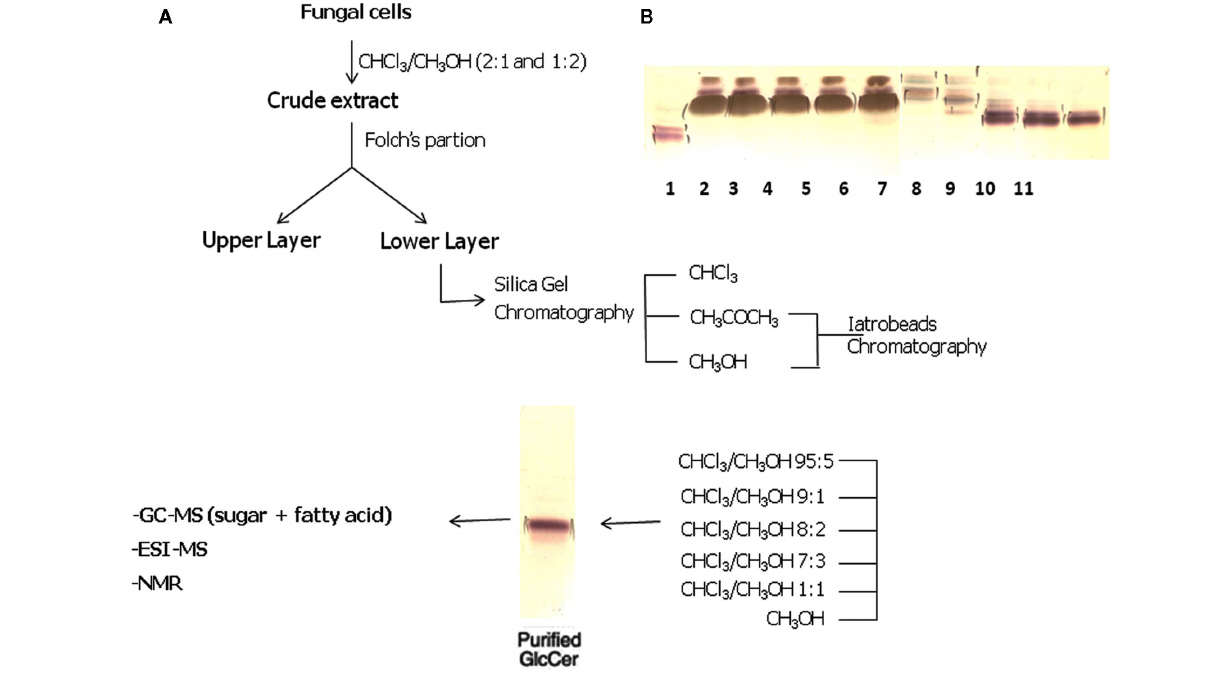
FIGURE 2 | (A) Overview of the strategy used for purification of CMHs from fungal cells. (B) High-performance thin-layer chromatography of fungal neutral glycosphingolipids isolated by silica gel column chromatography. Lane 1: cerebroside from bovine brain. Lanes 2–6: Chloroform–methanol (95:5v/v)